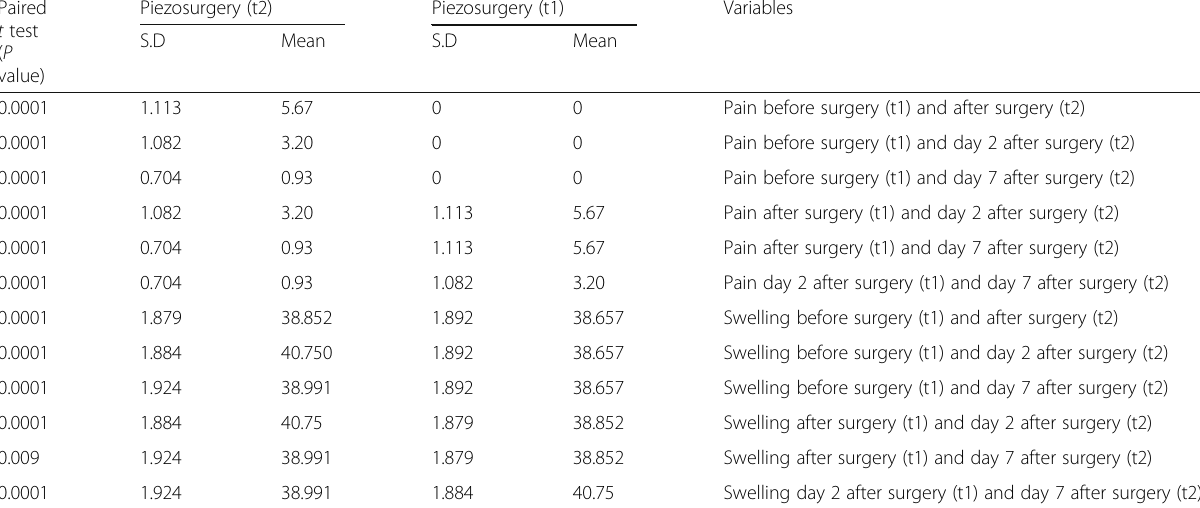
Table 5 Comparison of pain and swelling variables at different times of piezoelectric surgery Paired t test